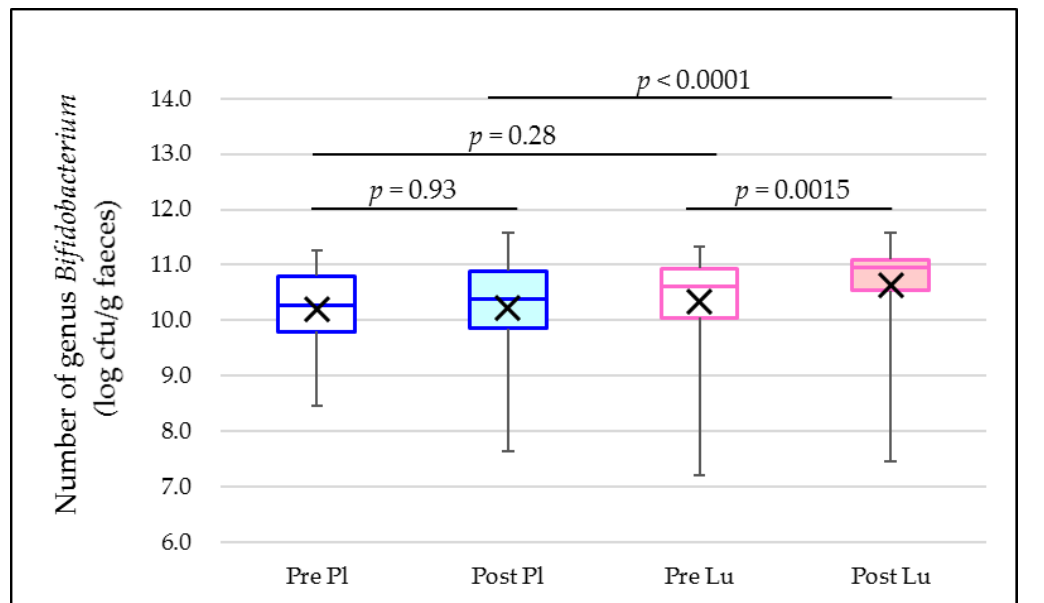
Figure A6. Comparison of the cell numbers of genus Bifidobacterium in faeces before intervention and after 2 weeks of intervention. Values are expressed as means (crosses) and quartiles. Pl, placebo; Lu, lactulose. p -values are for Pre Pl vs. Post Pl, Pre Lu vs. Post Lu, Pre Pl vs. Pre Lu, and Post Pl vs. Post Lu (paired t -test). CFU, colony-forming units.